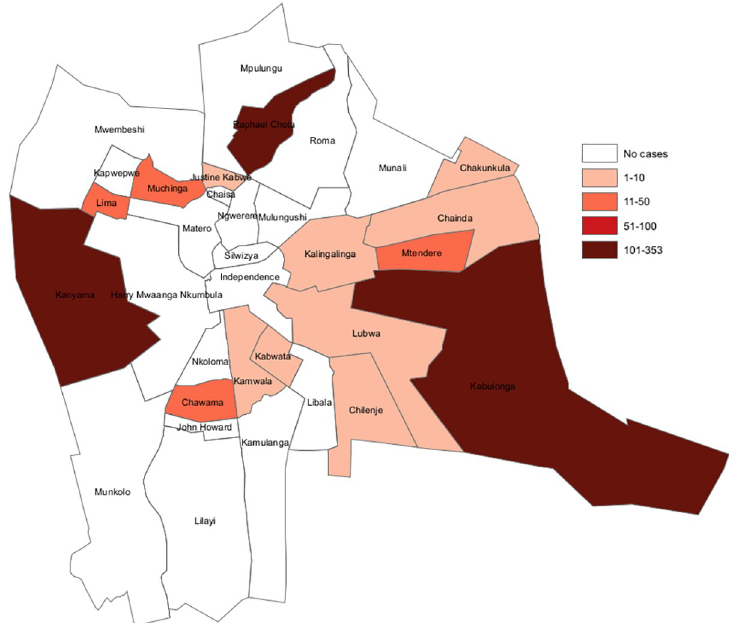
Fig 4. Cholera cases in Lusaka by ward, 2016–2018.